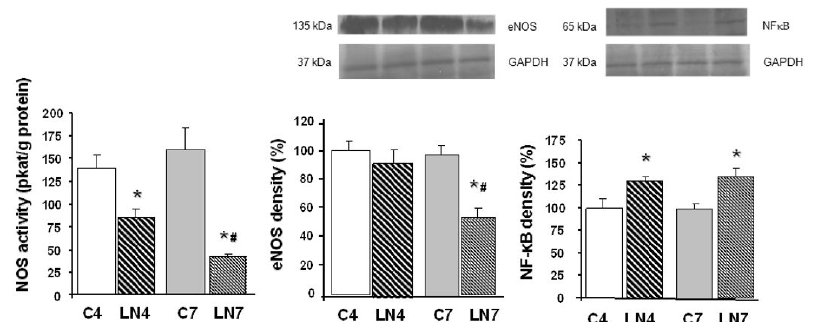
Figure 5. E ff ect of 4- and 7-week N G -nitro-L-arginine methyl ester (L-NAME) treatment on NO synthase (NOS) activity, endothelial NOS (eNOS) protein expression, and nuclear factor-kappaB (NF- κ B, p65) protein expression in the brainstem. Group treated with L-NAME for 4 weeks (LN4) and age-matched controls (C4), group treated with L-NAME for 7 weeks (LN7) and age-matched controls (C7). * p < 0.05 compared to age-matched controls, # p < 0.05 compared to LN4.